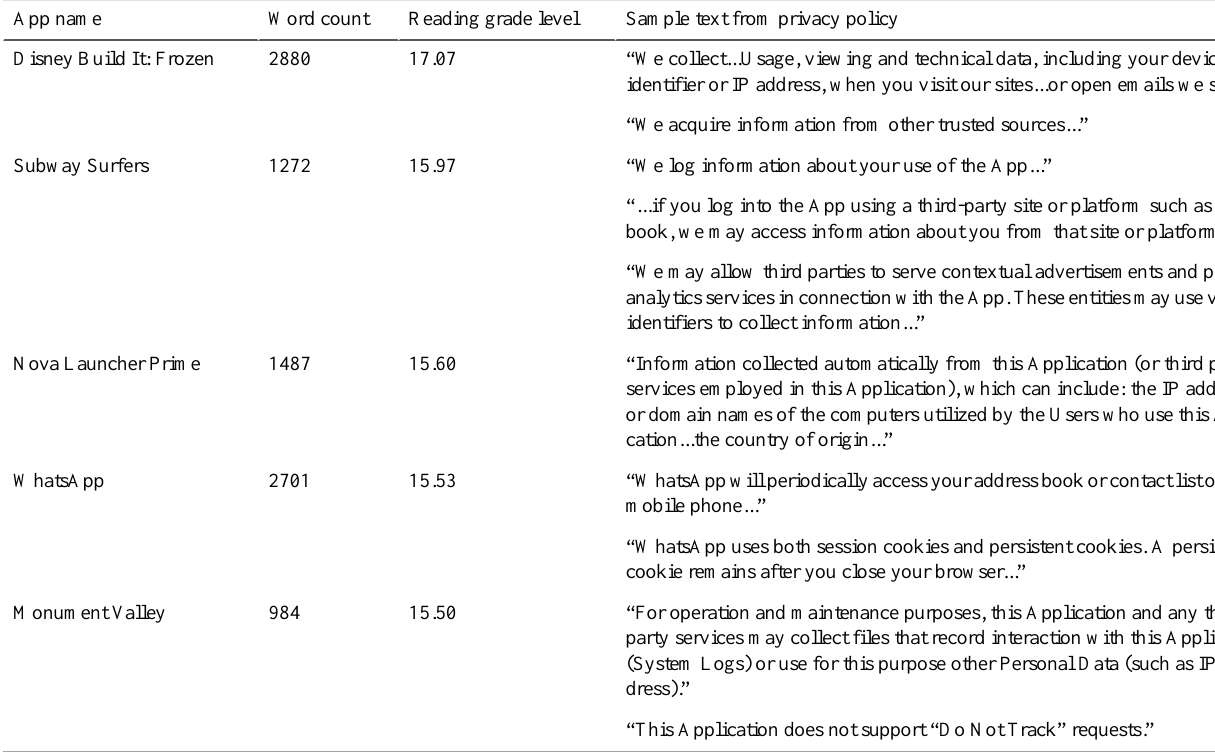
Table 4. Sample text from privacy policies with highest reading grade level (top